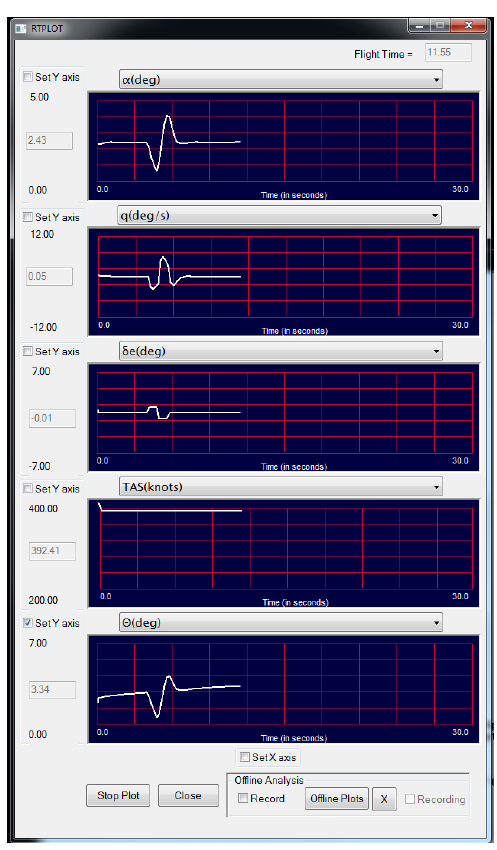
Figure 5. Simulation of a desired short period